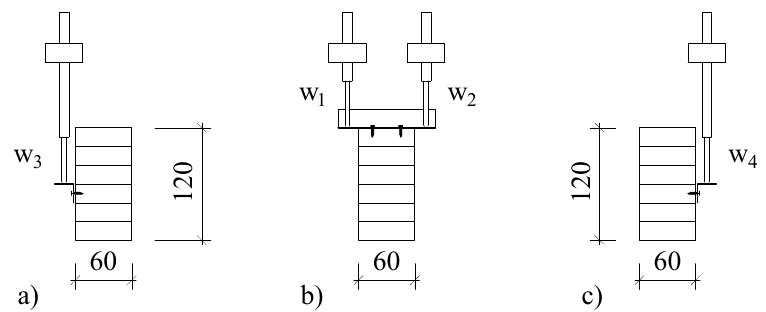
w 1 to w 4 ). The position of the sensors is shown in Figure 4.